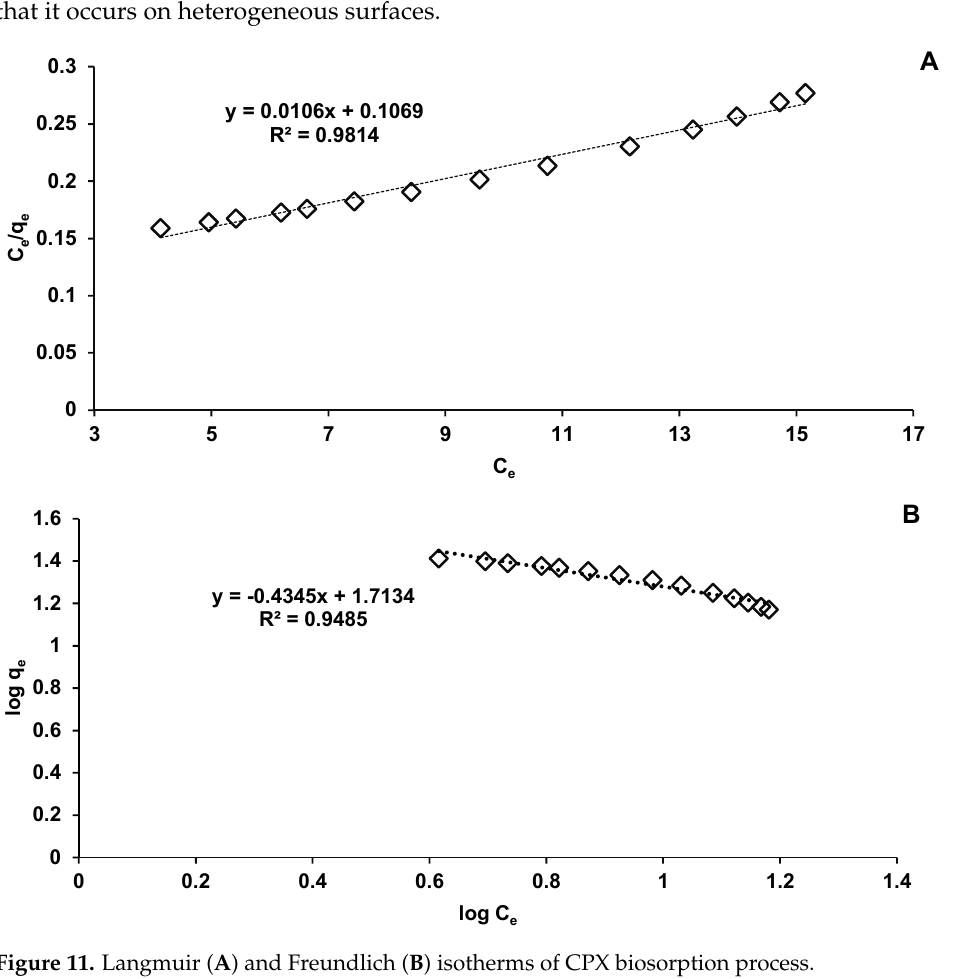
Table 2. Langmuir and Freundlich models of CPX biosorption process on Saccharomyces cere- visiae /calcium alginate beads